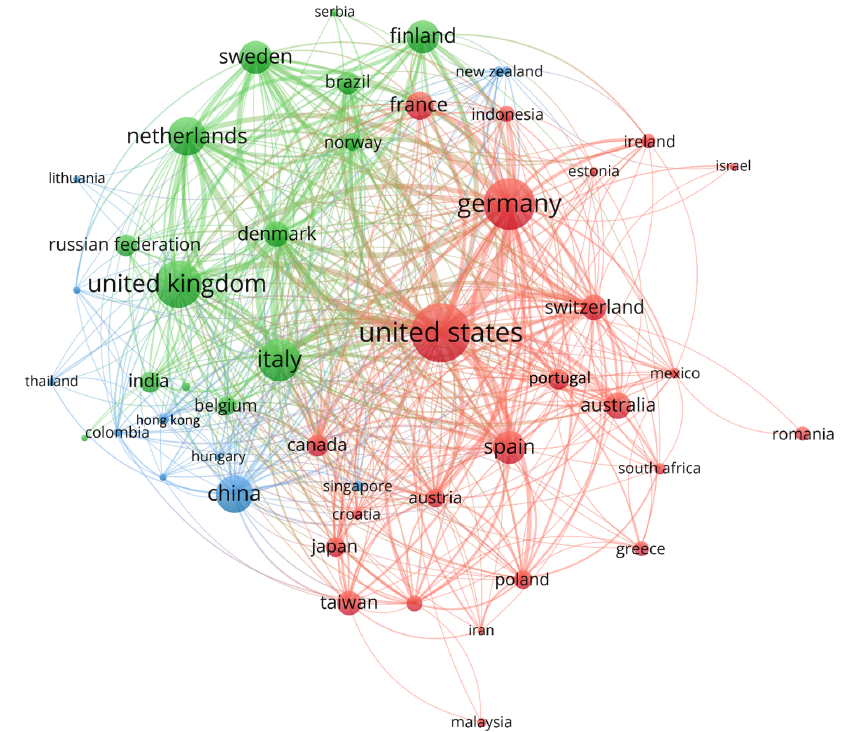
Figure 8. Citation network of countries in the BM&OI literature.